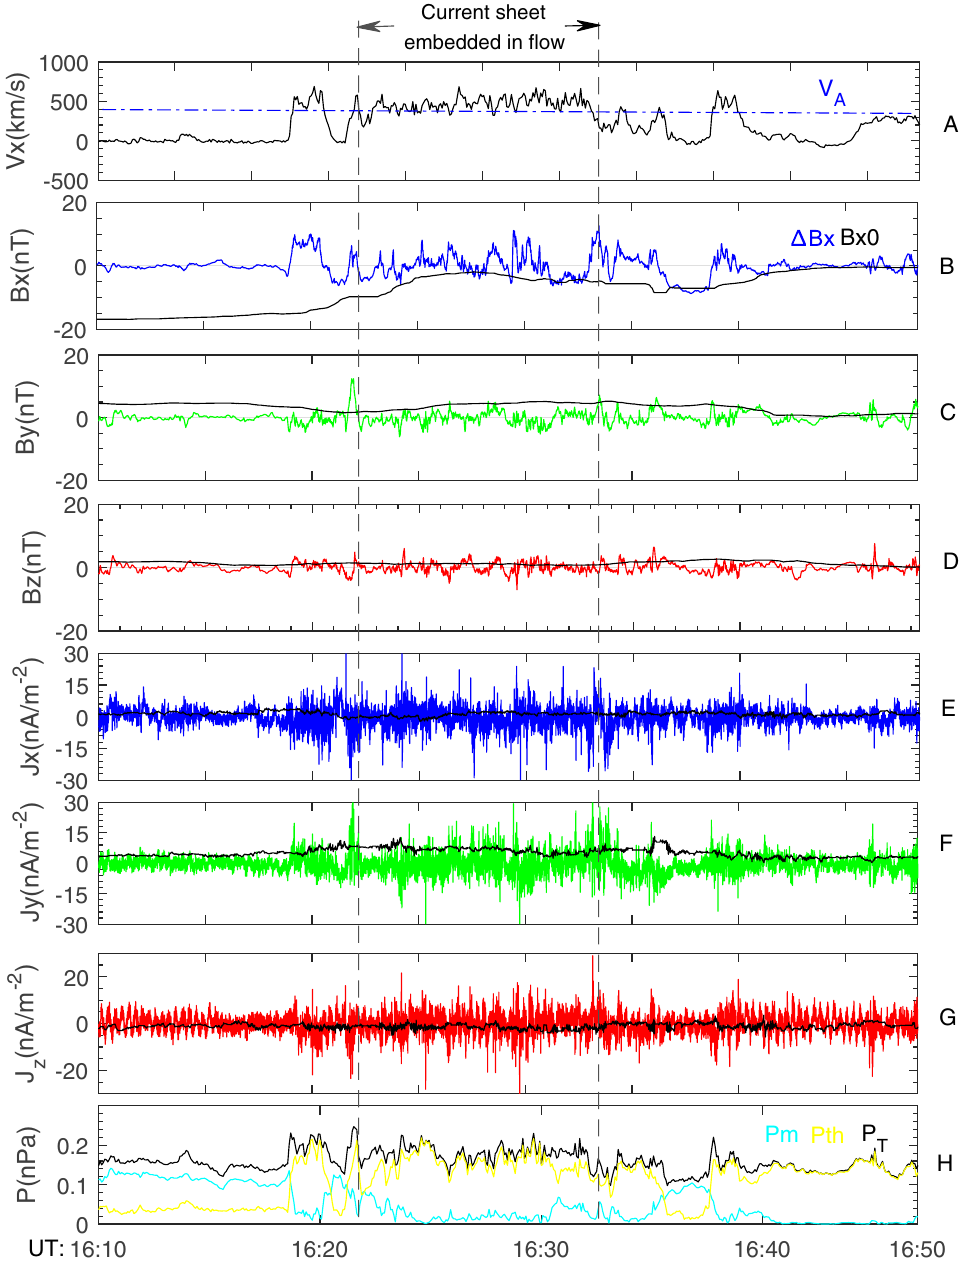
Figure 2. Turbulent current sheet without Bz-enhancement embedded in the earthward-traveling fast flow (same interval as Fig. 1). ( A )V x . ( B ) Perturbed Bx (∆B x ) and unperturbed Bx (B x0 ) (from a 5-min low-pass filter). ( C ) ∆B y and B y0 . ( D ) ∆B z and B z0 . ( E ) J x0 (calculated by unperturbed field). ( F ) J y0 . ( G ) J z0 . ( H ) Thermal pressure (P th ), magnetic pressure (P m ), and total pressure (P T